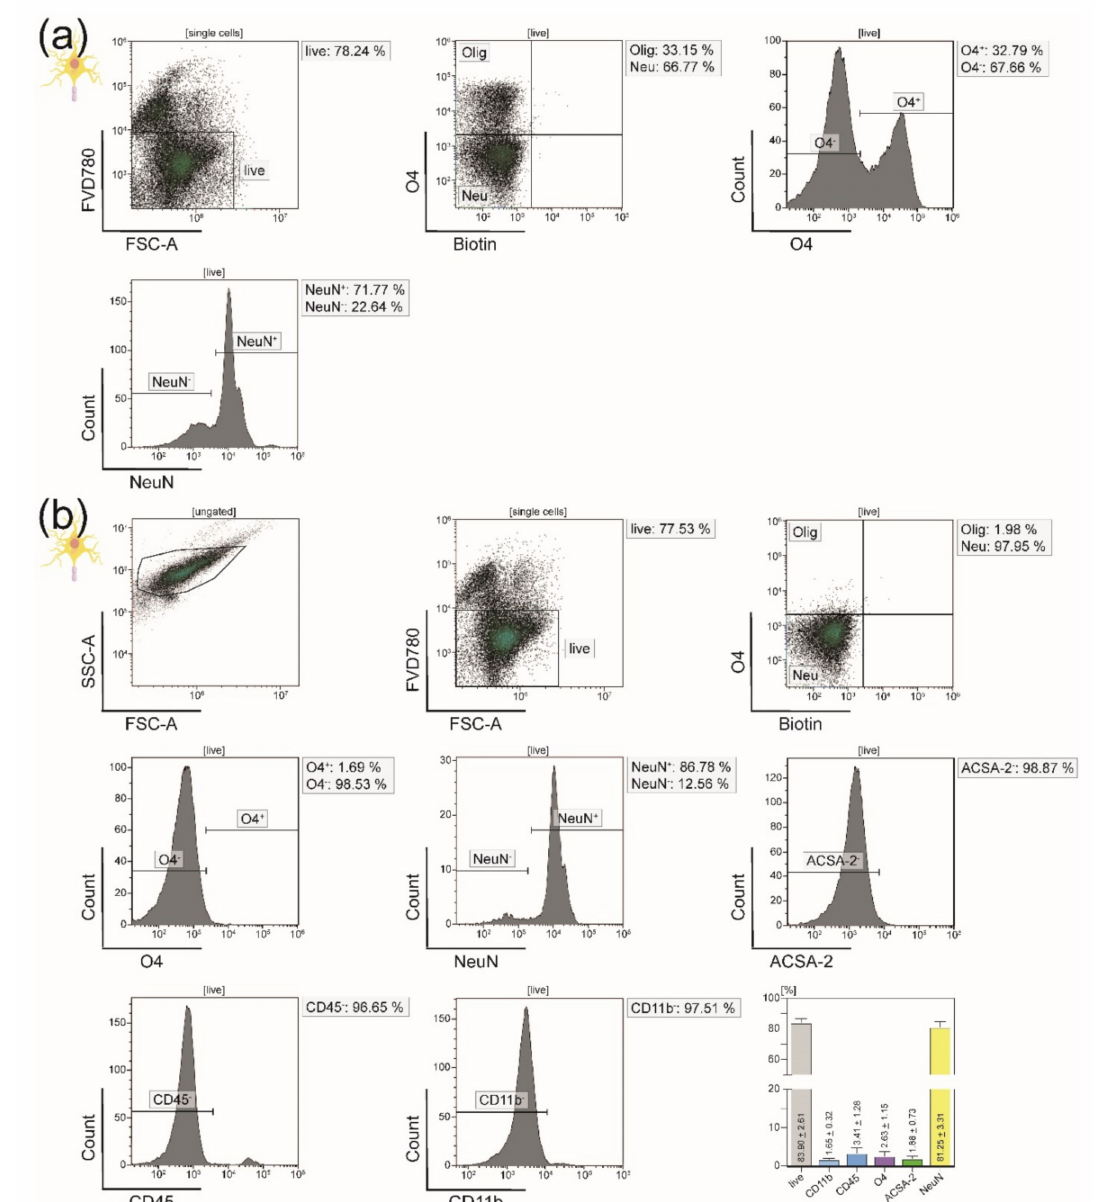
Figure 5. Flow cytometry analyses of neurons isolated from adult naïve mice. We used NeuN as a cell-type-specific marker for neurons. ( a ) Exemplary purity analysis of neurons isolated from adult naïve mice by depletion of all non-neuronal cells after labeling them with biotinylated antibodies and anti-biotin MicroBeads. Of the resulting single-cell suspension, 32.79% expressed the oligodendrocyte-specific surface marker O4. ( b ) Upon isolation of neurons from the negative flow-through of oligodendrocyte, the purity was increased to 81.25%. The bar diagram illustrates the viability and purity of the resulting single-cell suspension. Only 2.63% of the viable isolated cells were still O4 + after the protocol improvement. Five biological replicates were measured. Means ± SEMs are indicated in the bar